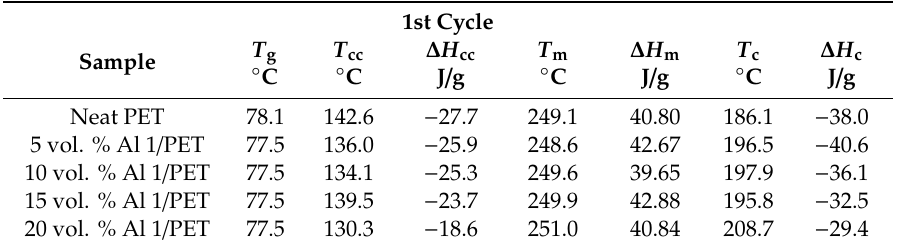
Table 4. Thermal parameters obtained from the first cycle of DSC thermographs of neat amorphous PET and micro Al 1 / amorphous PET composites (Figure 8). T g is the glass transition; T m is the melting peak temperature; T cc is cold crystallisation peak temperature from the amorphous state and T c is peak temperature for crystallisation from the